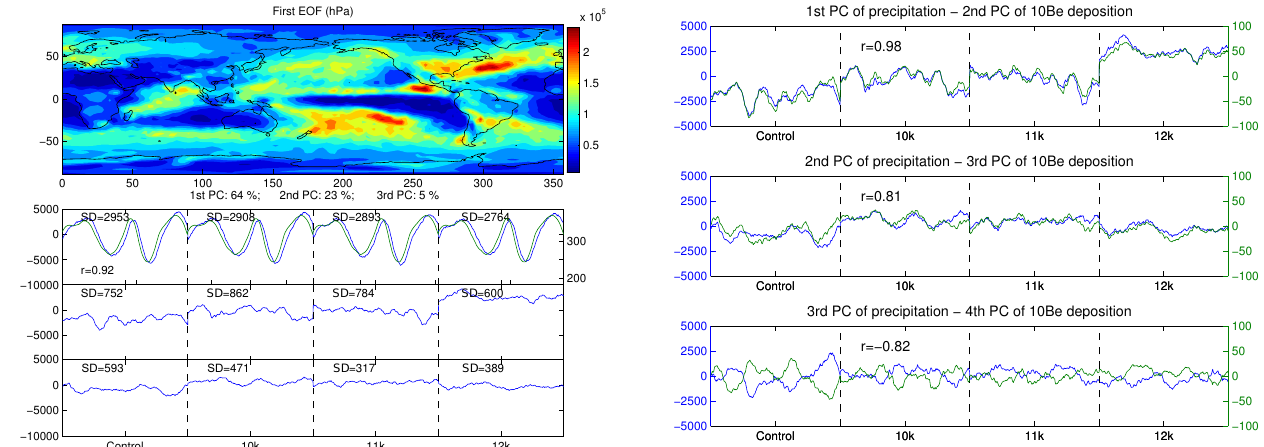
Fig. 2. First empirical orthogonal function (EOF) of the 25month running mean 10 Be deposition. Below the three first principal com- ponents (PCs) are shown together with the percentage of deposition variability explained by them for the four simulations (ctrl, 10k, 11k and 12k). “SD” shows the standard deviation of each PC. In addi- tion to the first PC the top panel shows the global 10 Be production rate in green and the correlation coefficient with the first PC. Units are normalised.